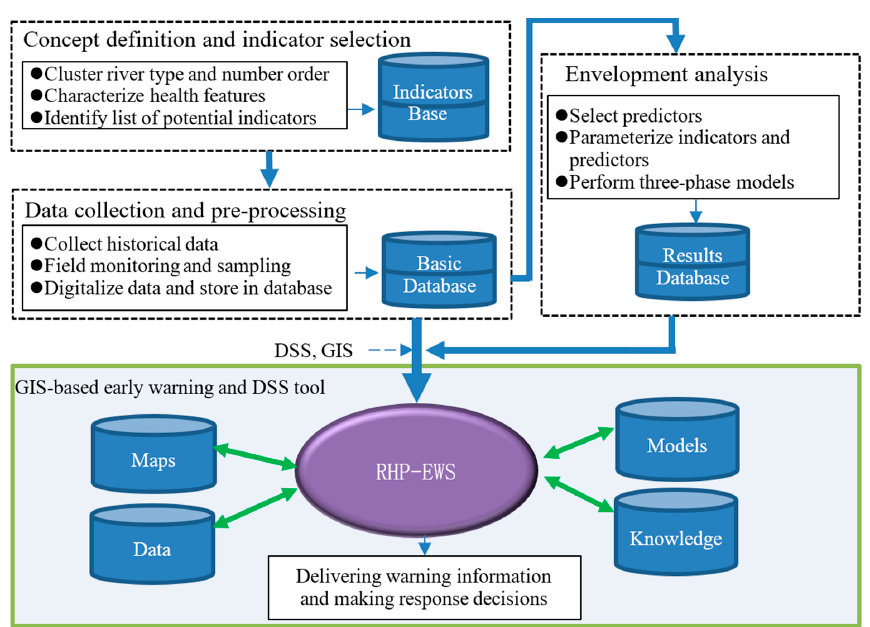
Figure 2. Conceptual framework of a river health early warning system based on the three-phase approach.